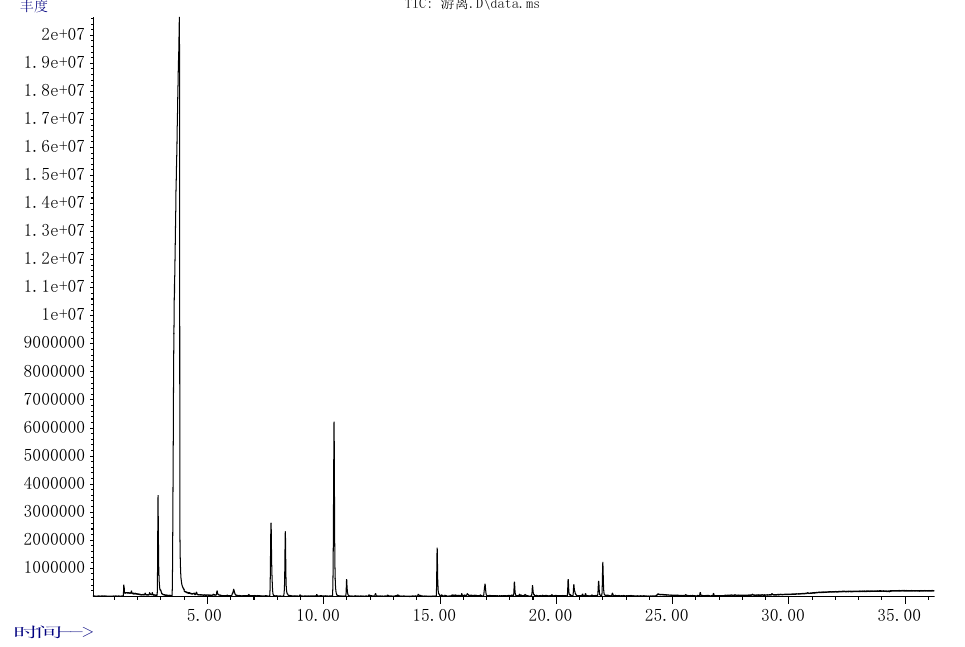
Figure 5. GC–MS total ion outflow Figure of aroma components of red raspberry wine fermented with free